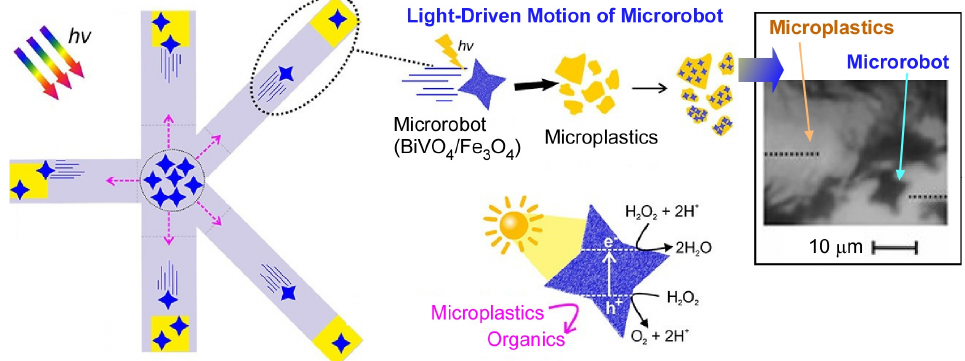
Figure 15. Microrobots capable of moving by visible light and capturing/degrading microplastics in a complex multichannel maze. Reprinted with permission from Reference [159]. Copyright 2021 American Chemical Society.